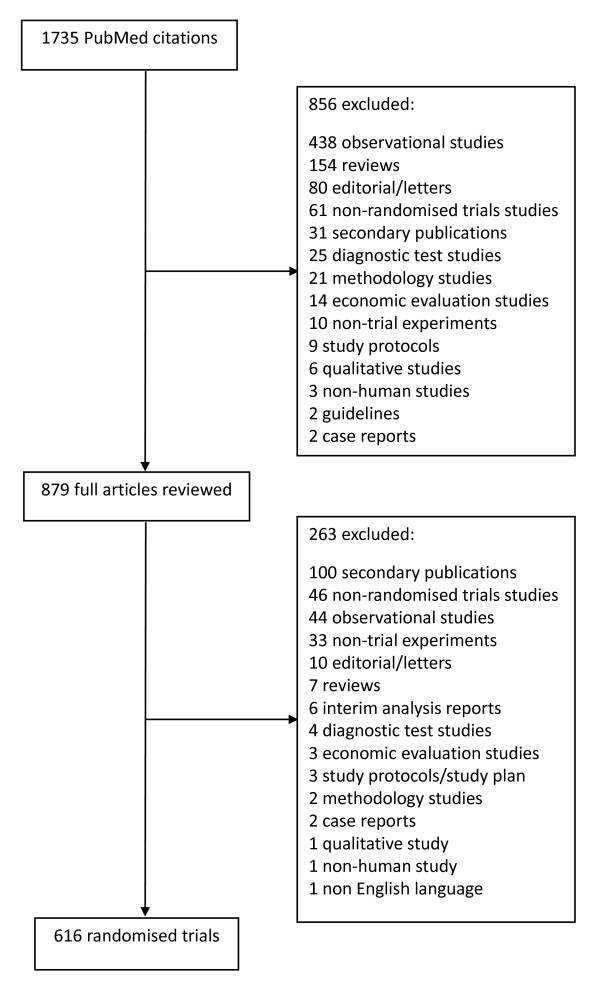
Flow Chart of December 2006 Articles Eligible for Review.